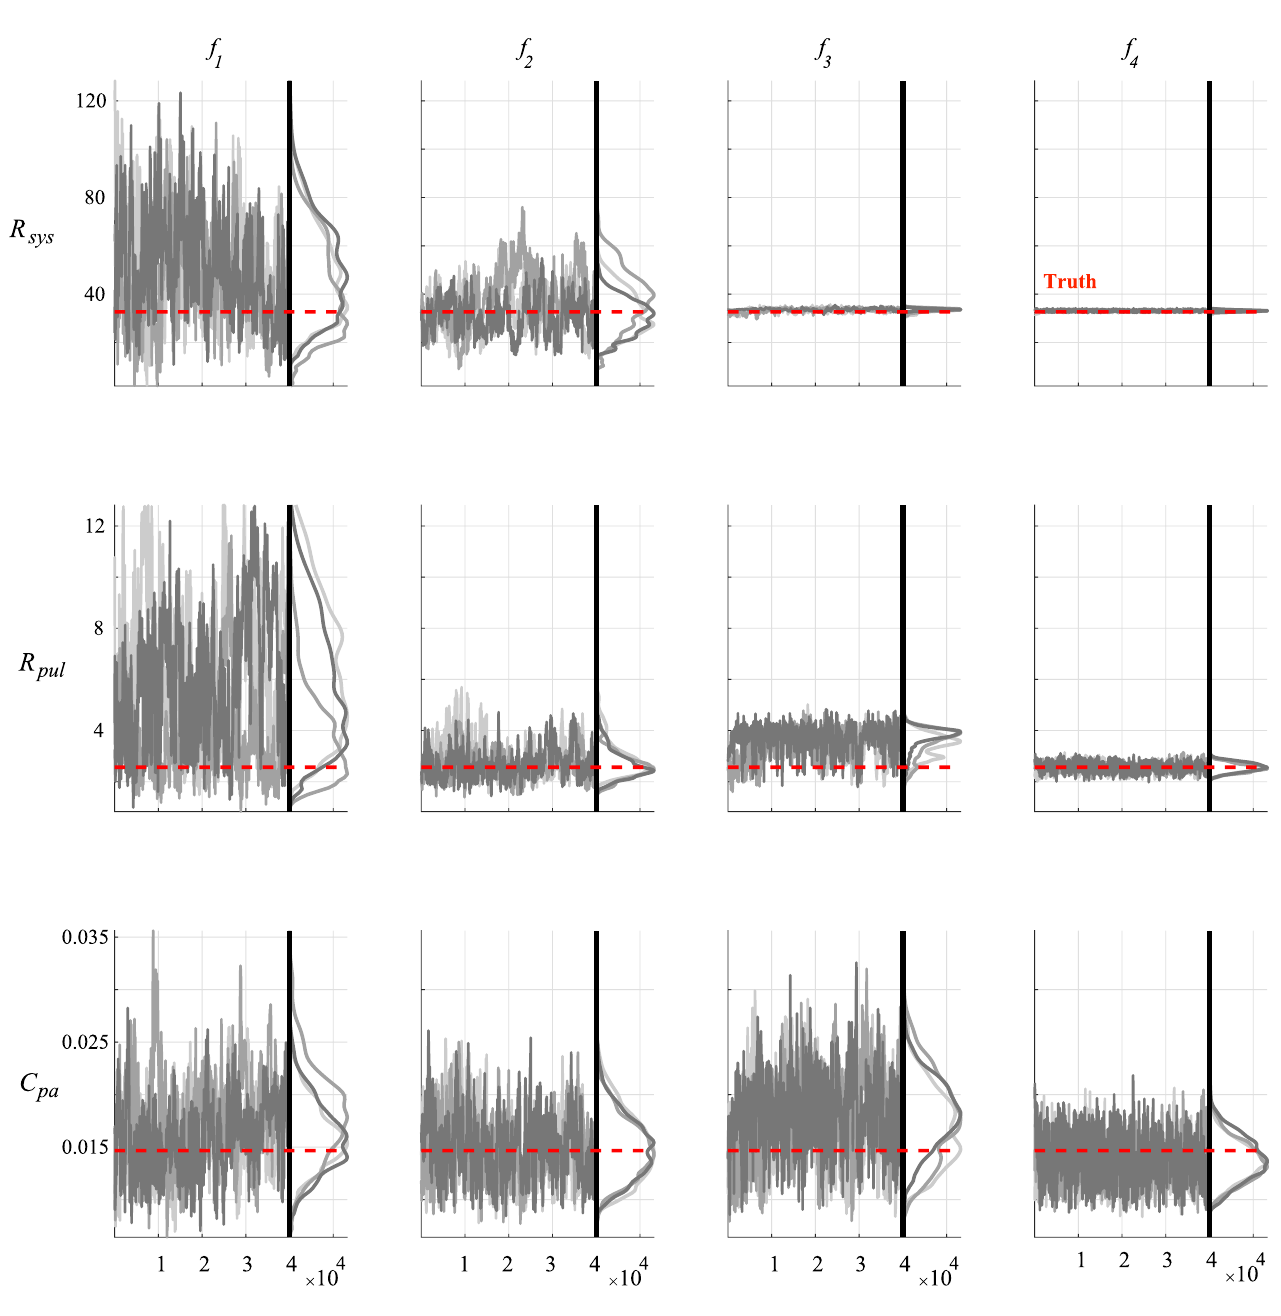
Fig 8. Chain iterations and marginal posteriors after MCMC for the hemodynamic compartment parameters. As in Figs 6 and 7, three of the twelve MCMC instances are provided for systemic vascular resistance, R marginal posteriors do contain the true parameters (in red) within the marginal posteriors for the simplest design ( f 1 , first column), additional data in the other designs substantially reduce posterior